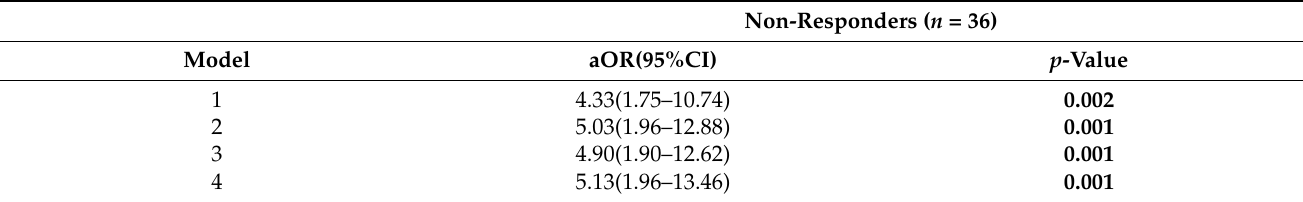
Table 5. Odds ratios for incidence of hormonal and radiologic non-responders according to hormone